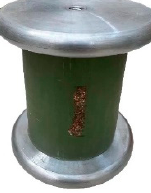
Figure 17. Metal filth discharge defect.